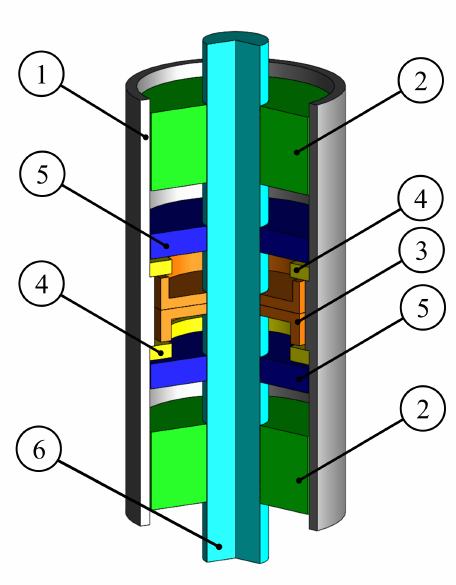
Figure 1. 3D cross-section view of the proposed FESS layout: 1 (cid:13) Rotor; 2 (cid:13) Hysteresis self-bearing drive; 3 (cid:13) Thrust AMB; 4 (cid:13) Flange; 5 (cid:13) Backup bearing; 6 (cid:13) Inner